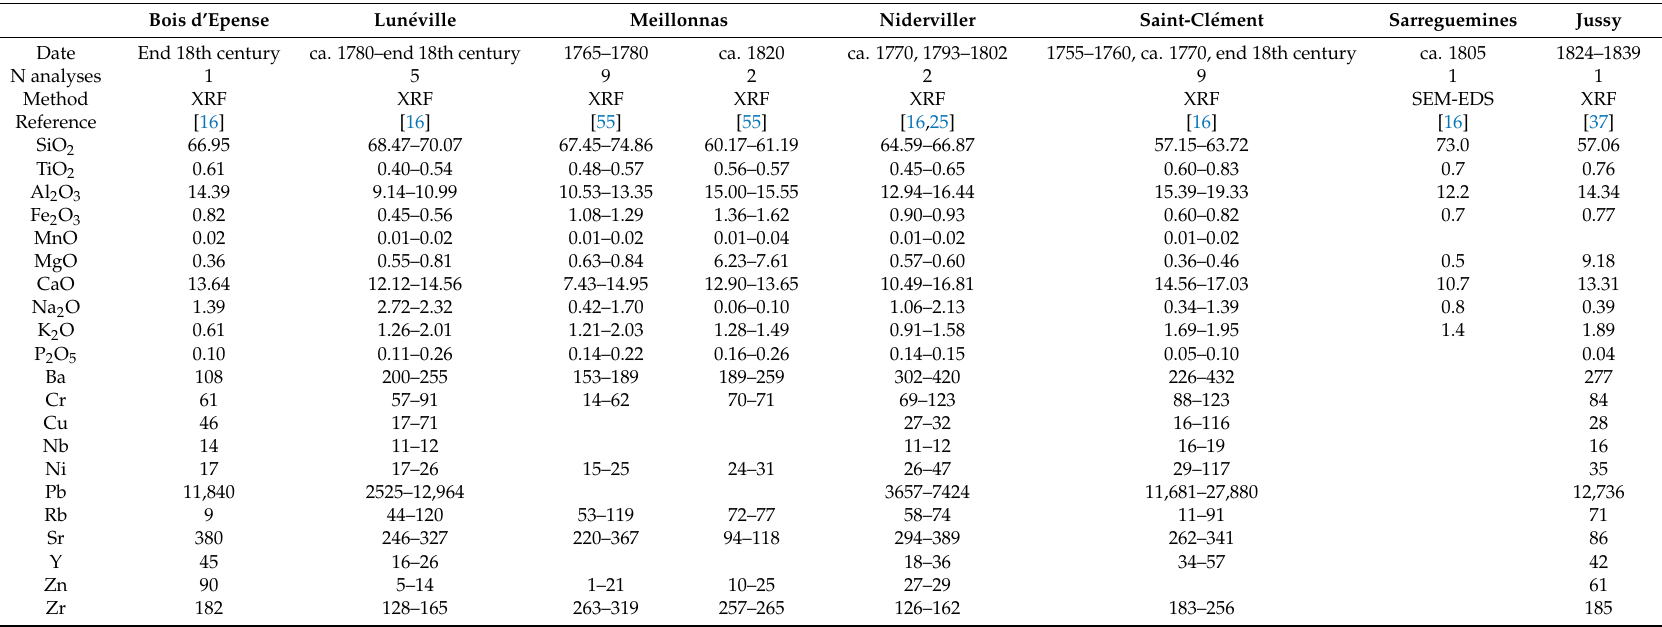
Table 4. Chemical compositions (Min.–Max.) of French CaO-rich white earthenware . Oxides in wt %, elements in